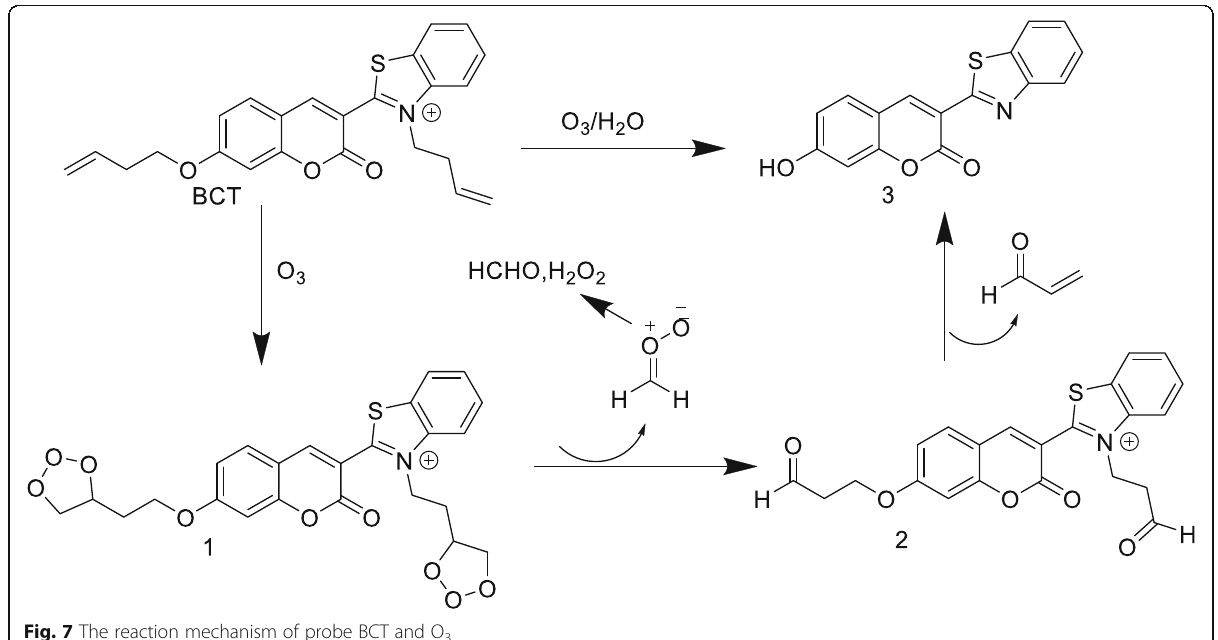
Fig. 7 The reaction mechanism of probe BCT and O 3